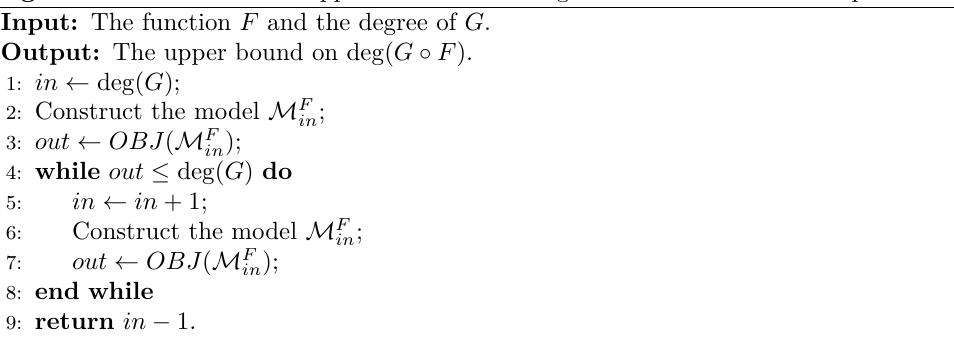
Algorithm 1 Calculate the upper bound on the degree of G ◦ F based on Proposition